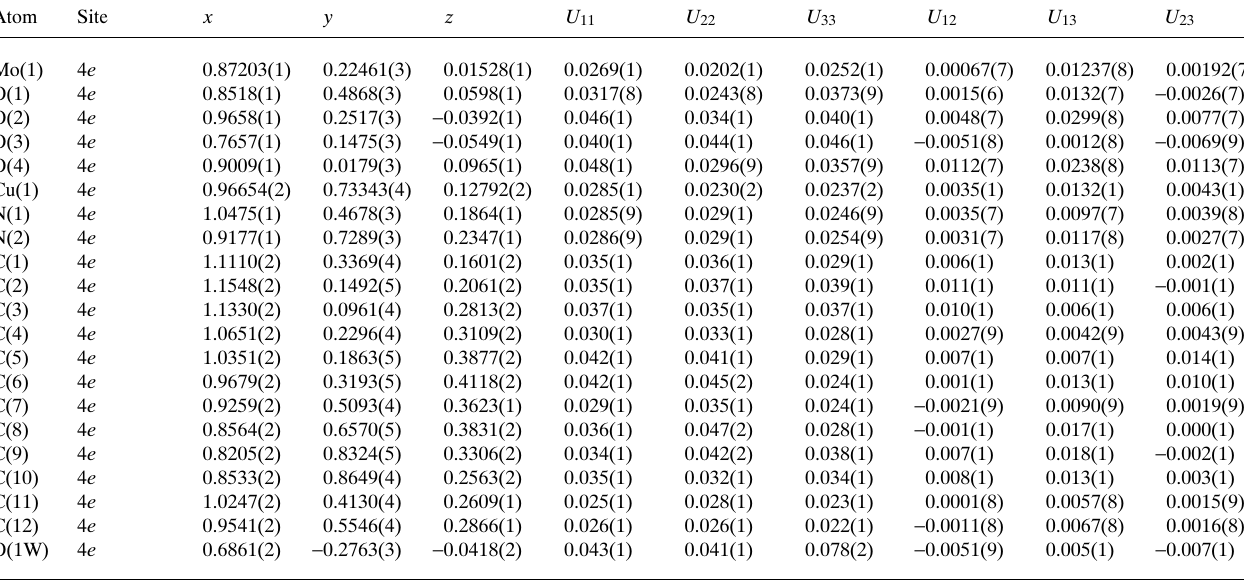
Table 3. Atomic coordinates and displacement parameters (in Å 2 ) .